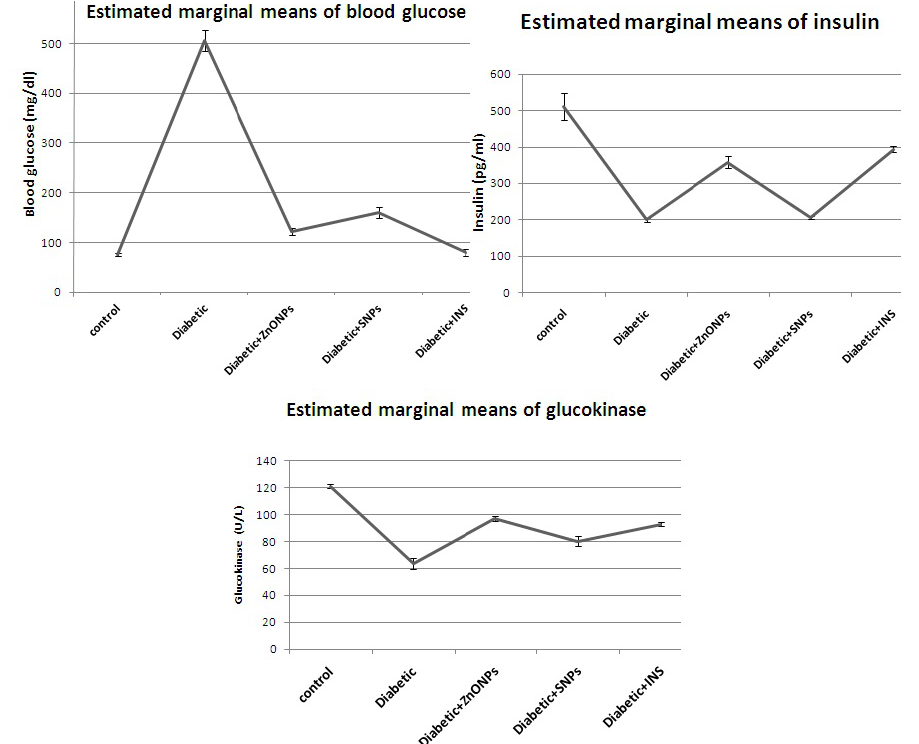
Figure 1. Estimated marginal means of blood glucose level (mg/dL), insulin level (pg/mL) and glucokinase activity (U/L).